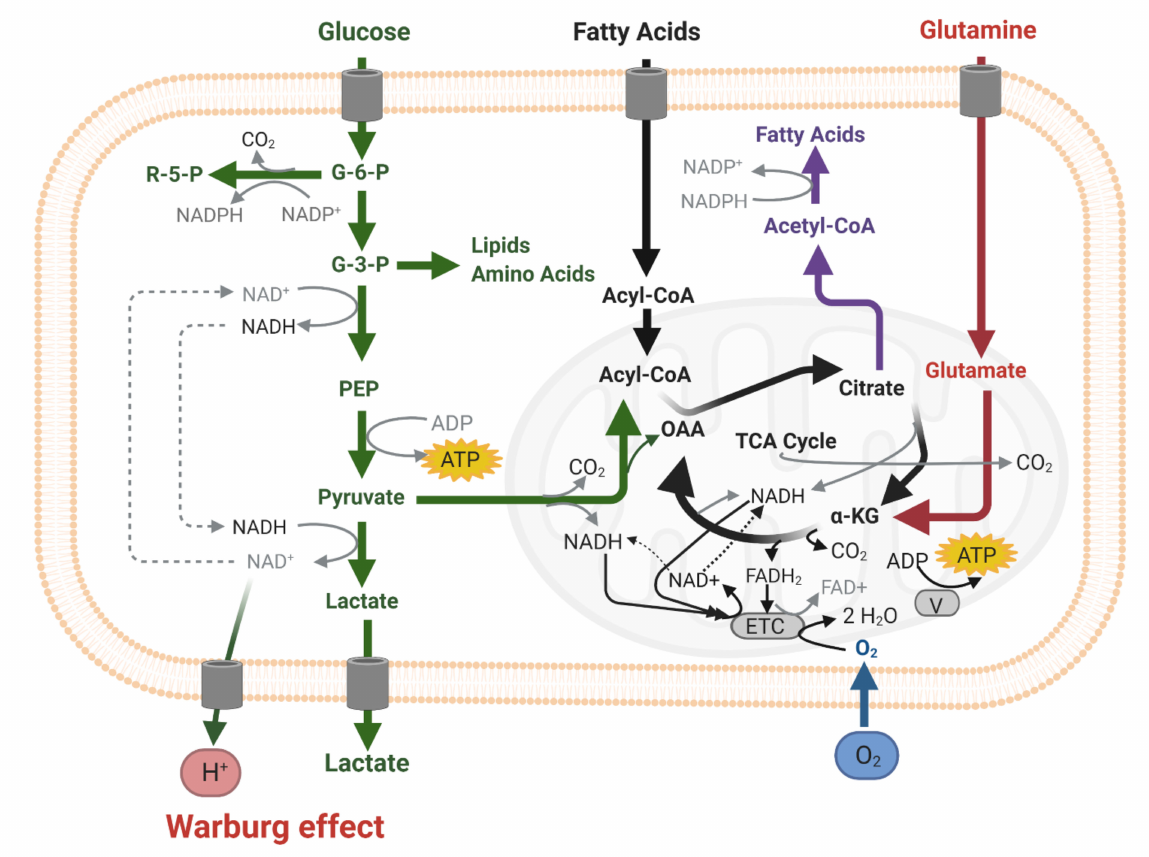
Figure 1. Scheme of cellular energy metabolism (ATP production) in the cytoplasm (glycolysis, green) and in mitochondria oxidative phosphorylation (OXPHOS) via the electron transport chain (ETC, grey) with the use of oxygen (blue). Substrate for glycolysis is (extracellular) glucose and for OXPHOS pyruvate (from the cytoplasm, green), or (extracellular) fatty acids (black), or (extracellular) glutamine and/or glutamate